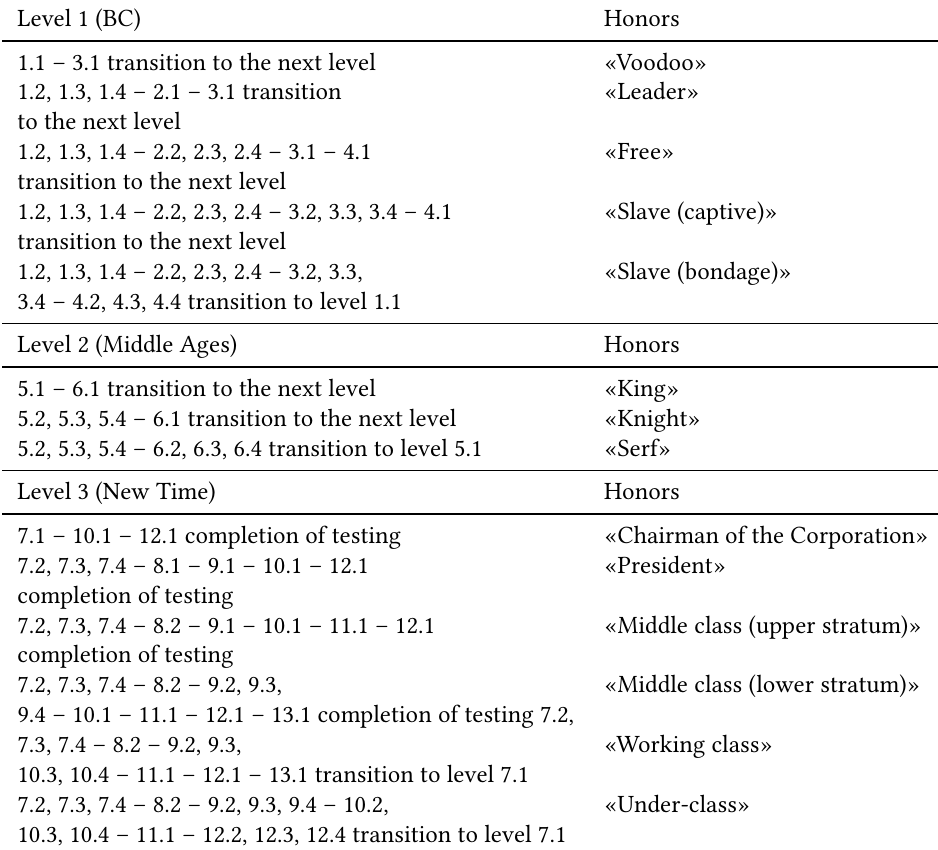
Possible trajectories of the